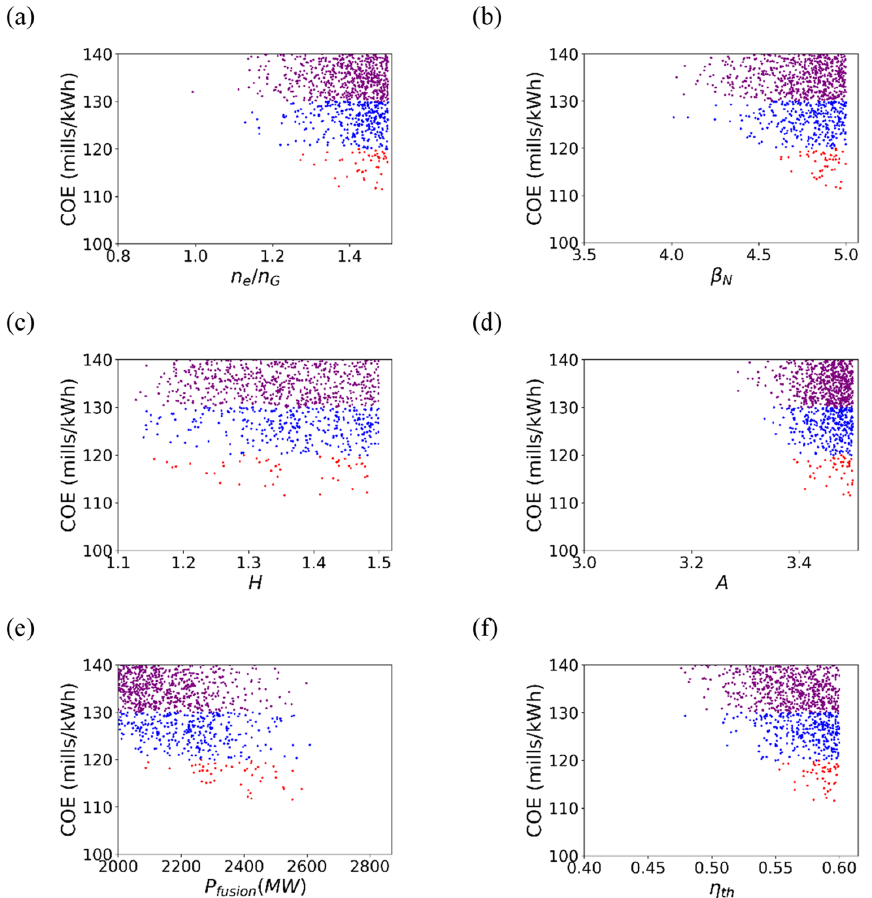
Figure 4. Variation of COE (red for COE ≤ 120 mills/kWh, blue for 120 mills/kWh < COE ≤ 130 mills/kWh, and purple for 130 mills/kWh < COE ≤ 140 mills/kWh) on the required physics and system parameters when R 0 ≤ 6.2 m for the case with the CS: ( a ) n e /n G ; ( b ) β N ; ( c ) H ; ( d ) A ; ( e ) P fusion , and ( f ) η th .